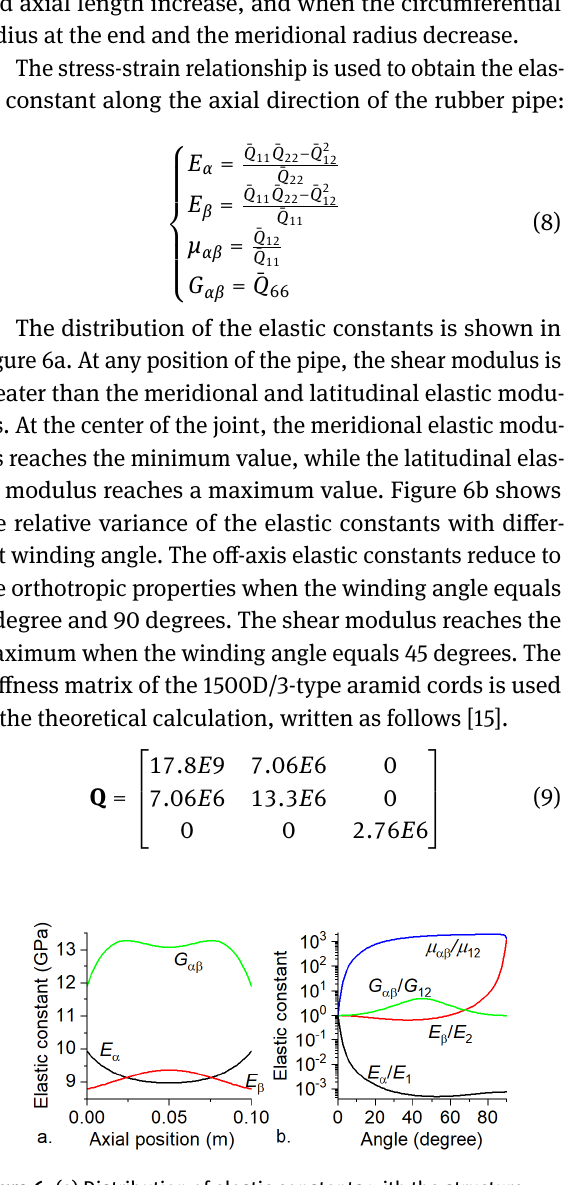
Figure 6: (a) Distribution of elastic constants with the structure vector H = [0.1, 0.1, 0.1, 40] . (b) The elastic constants at variant winding